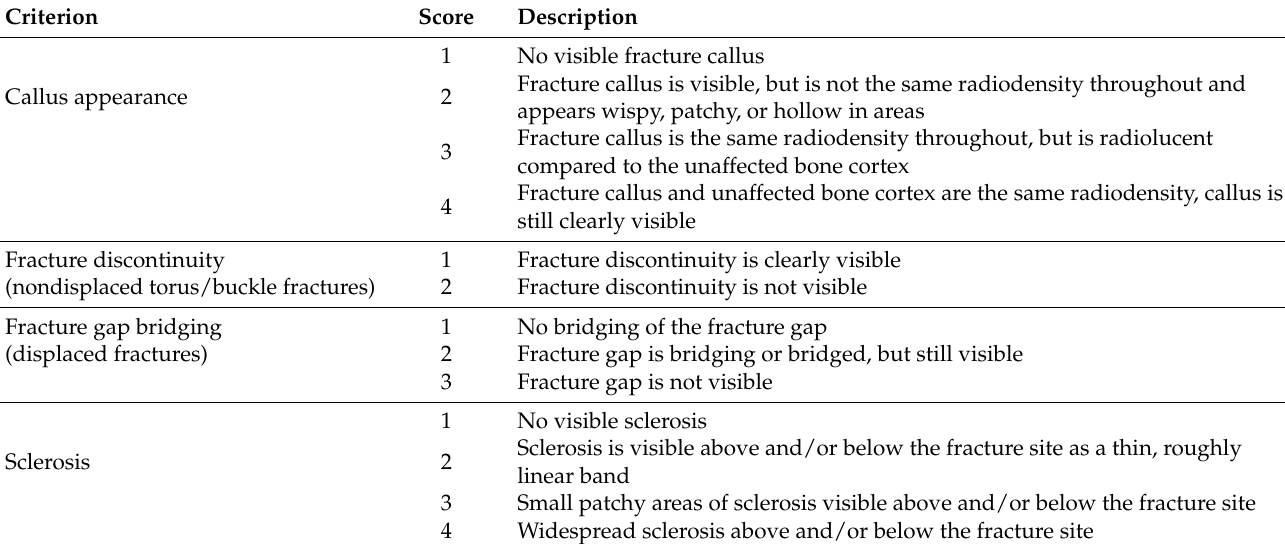
Table 2. Newly developed criteria used to score fracture healing in this